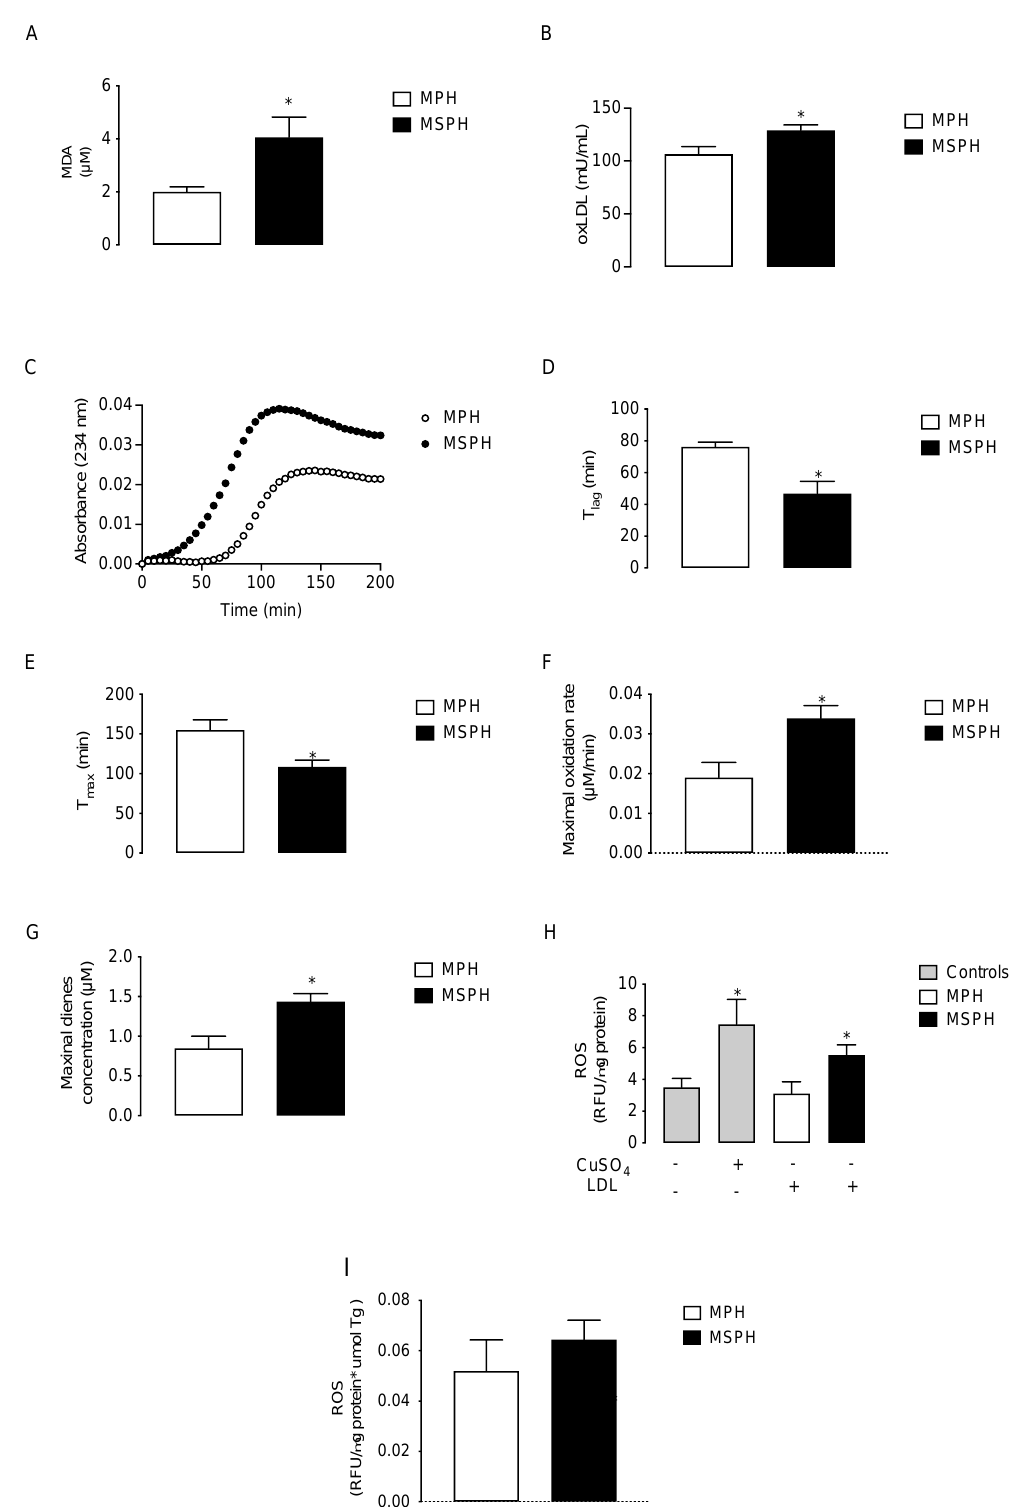
Figure 5. Oxidative status of maternal plasma and LDL from MPH and MSPH pregnancies. Levels of malondialdehyde (MDA, ( A )) and oxidized LDL (oxLDL, ( B )) determined in total serum of MPH (white) and MSPH (black) women ( n = 12 per group). C-G, kinetic parameters obtained from conju- gated dienes formation assay in LDL isolated form MPH (white) and MSPH (black) maternal serum ( n = 10 per group): ( C ) kinetic of conjugated dienes formation; ( D ) duration of the lag-phase (T lag); ( E ) time of maximal formation of dienes (T max); ( F ) maximal concentration of dienes and ( G ) oxi- dation rate of LDL. ( H , I ) Pro-oxidant capacity of LDL from MPH and MSPH women. ( H ) Total levels of reactive oxygen species (ROS) were determined in control HUVEC (grey) or HUVEC incubated with the following: CuSO4 (gray), LDL isolated from MPH (white) or MSPH (black) maternal serum. ( I ) Levels of ROS were determined in HUVEC incubated with LDL isolated from MPH (white) or